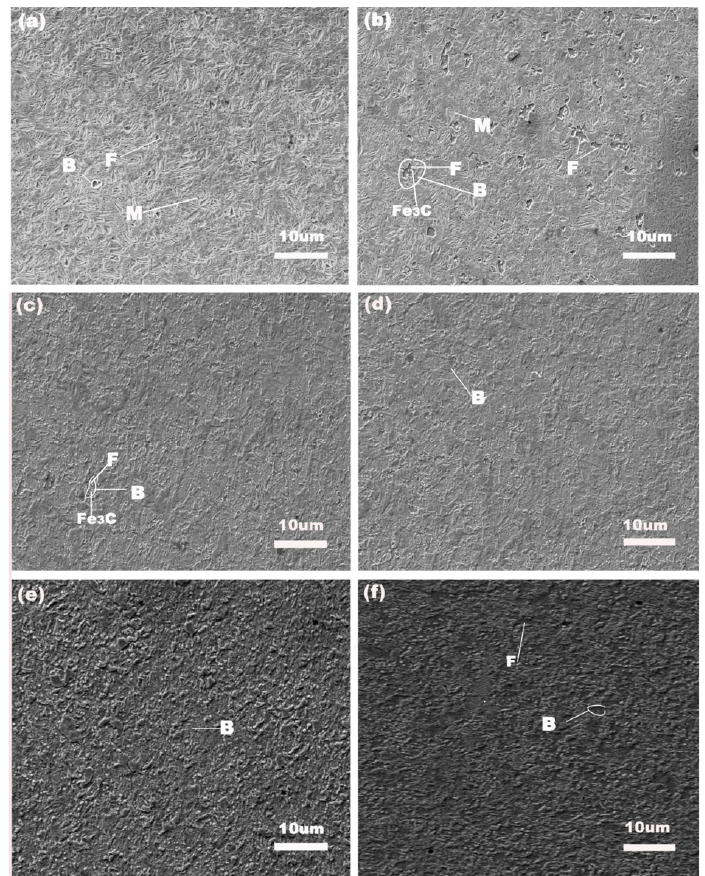
Figure 10. The scanning electron microscope (SEM) image at: ( a ) location C1 with a 300 ℃ die temperature, ( b ) location C2 with a 500 ℃ die temperature, ( c ) location H1 with a 400 ℃ die temperature, ( b ) location C2 with a 500 ◦ C die temperature, ( c ) location H1 with a 400 ◦ C die temperature, ( d ) location H2 with a 400 ℃ die temperature, ( e ) location H1 with a 500 ℃ die temperature, ( d ) location H2 with a 400 ◦ C die temperature, ( e ) location H1 with a 500 ◦ C die temperature, and ( f ) location H1 with a 600 ℃ die temperature. temperature, and ( f ) location H1 with a 600 ◦ C die temperature.